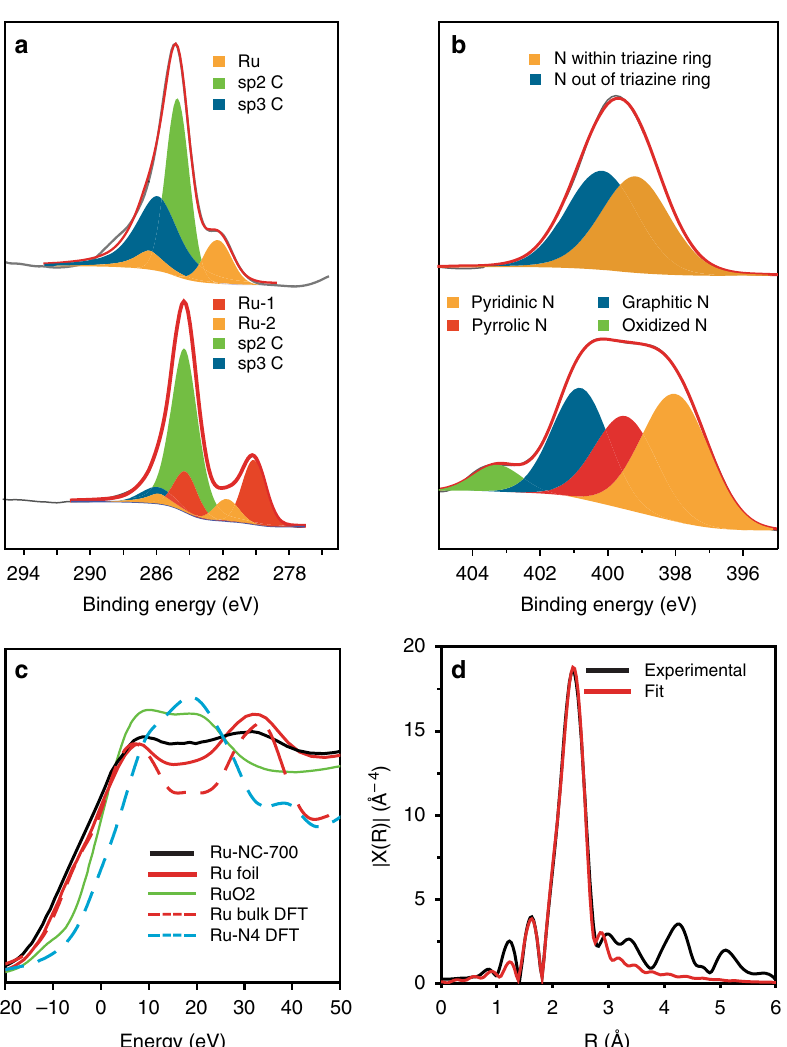
Fig. 3 X-ray photoelectron spectroscopic and X-ray absorption spectroscopic studies. a C 1s and Ru 3d spectra of Ru-MF (upper panel) and Ru-NC-700 (lower panel). b N 1s spectra of Ru-MF (upper panel) and Ru-NC-700 (lower panel). Black curves are experimental data, shaded peaks are deconvolution fi ts, and red curves are the sum of the fi ts. c Normalized X-ray absorption near edge structure data for Ru-NC-700, solid lines are experimental data and dash lines are simulated data by density functional theory calculations. d Fourier transform of extended X-ray absorption fi ne structure data for Ru-NC- 700, where black curve is experimental data and red curve is the best fi